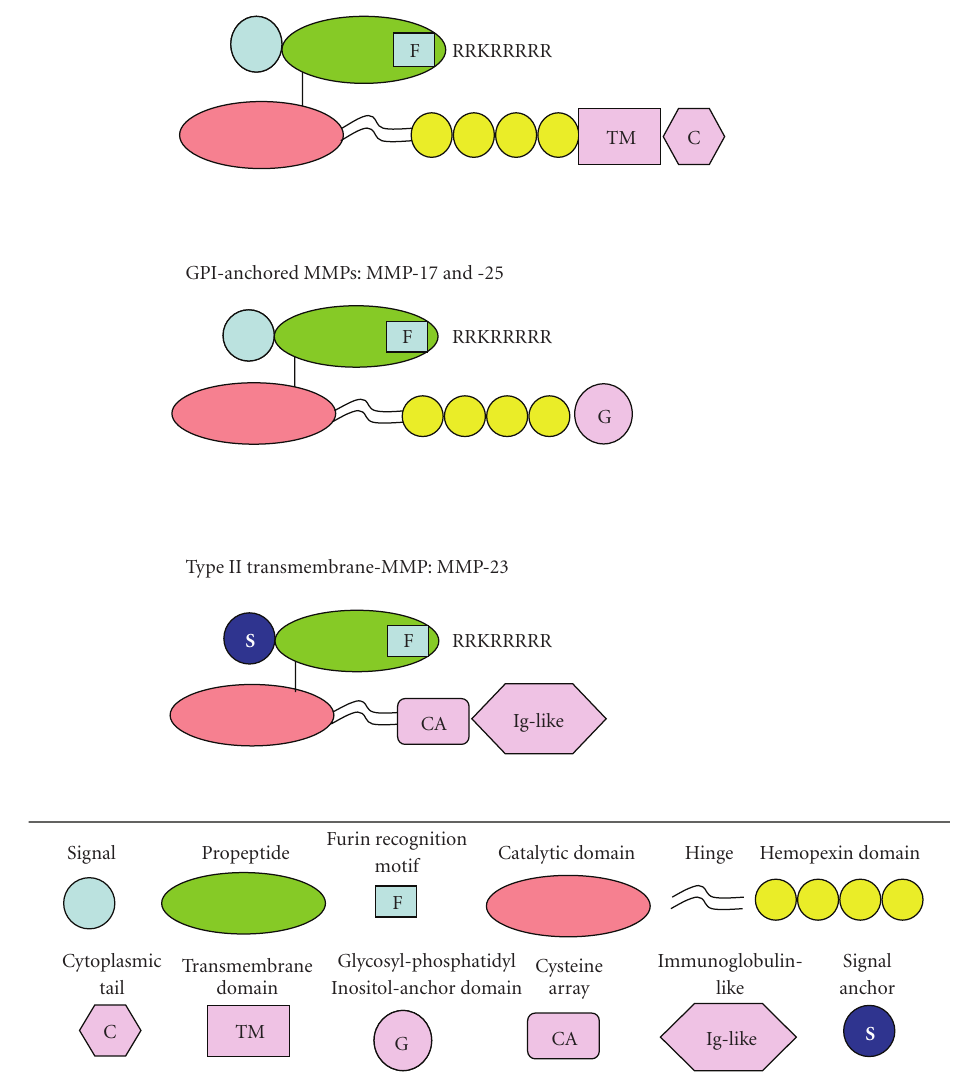
Figure 2: Primary structure of membrane-anchored